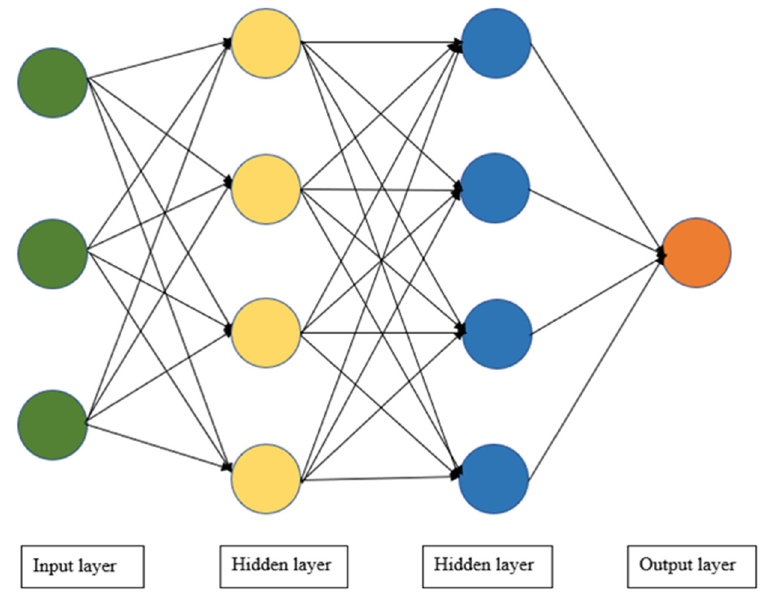
Figure 2. Neural network structure.